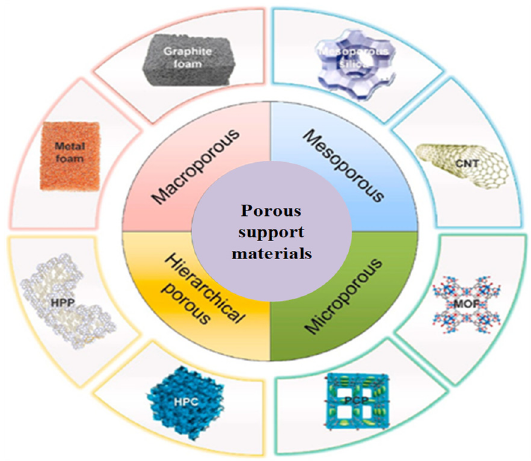
Figure 15. Porous support materials [114,115], reprinted/adapted with permission from Ref. [114], 2022, Elsevier.